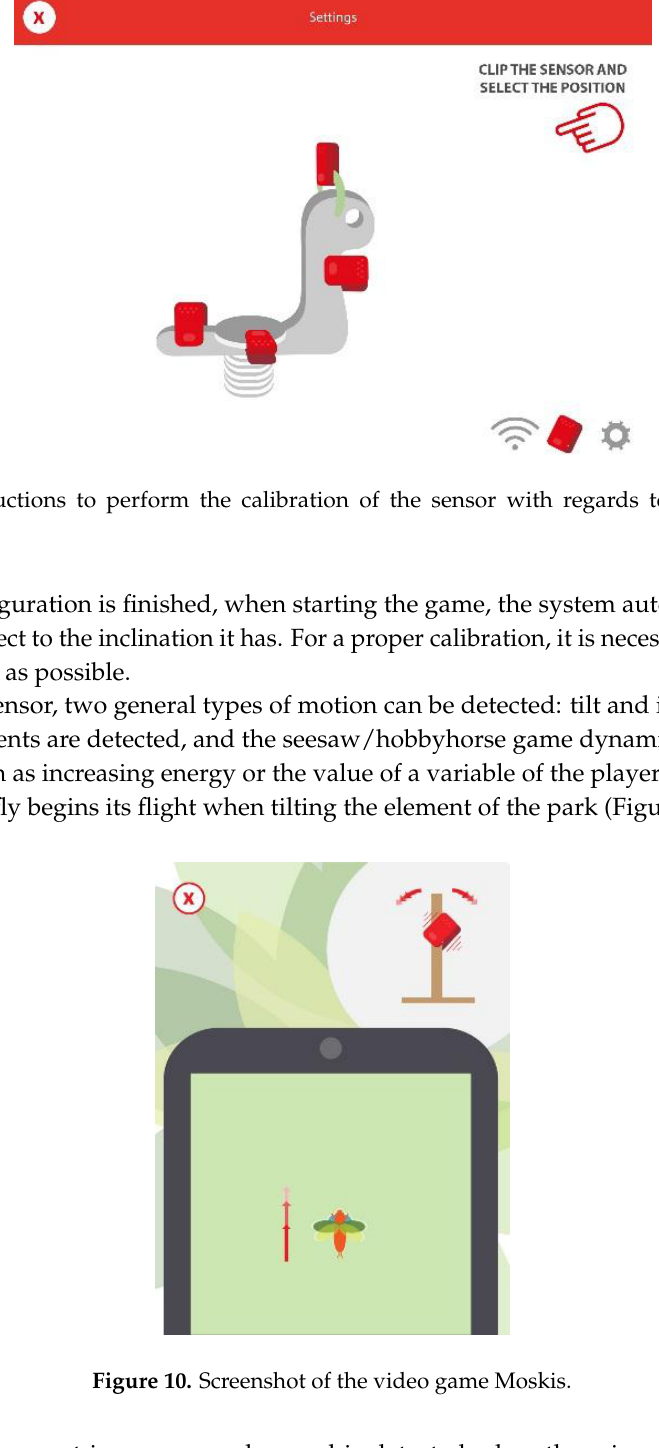
Figure 11. Screenshot of the adaptation of the classic arcade video game Pac Man. The effect of the inclination in the game can be digital (activating a predefined movement speed) or analog, so that the speed of the associated action is related to the value of the inclination angle. 3.4.2. The Swing In the case of the swing, the sensor must be coupled to the base thereof facing the floor, so that it can be detected. When the child sways, the sensor recognizes everytime that the swing is closer to the ground (Figure 12). In this way, the swinging speed can be calculated, since the cutting period is higher or lower depending on it.